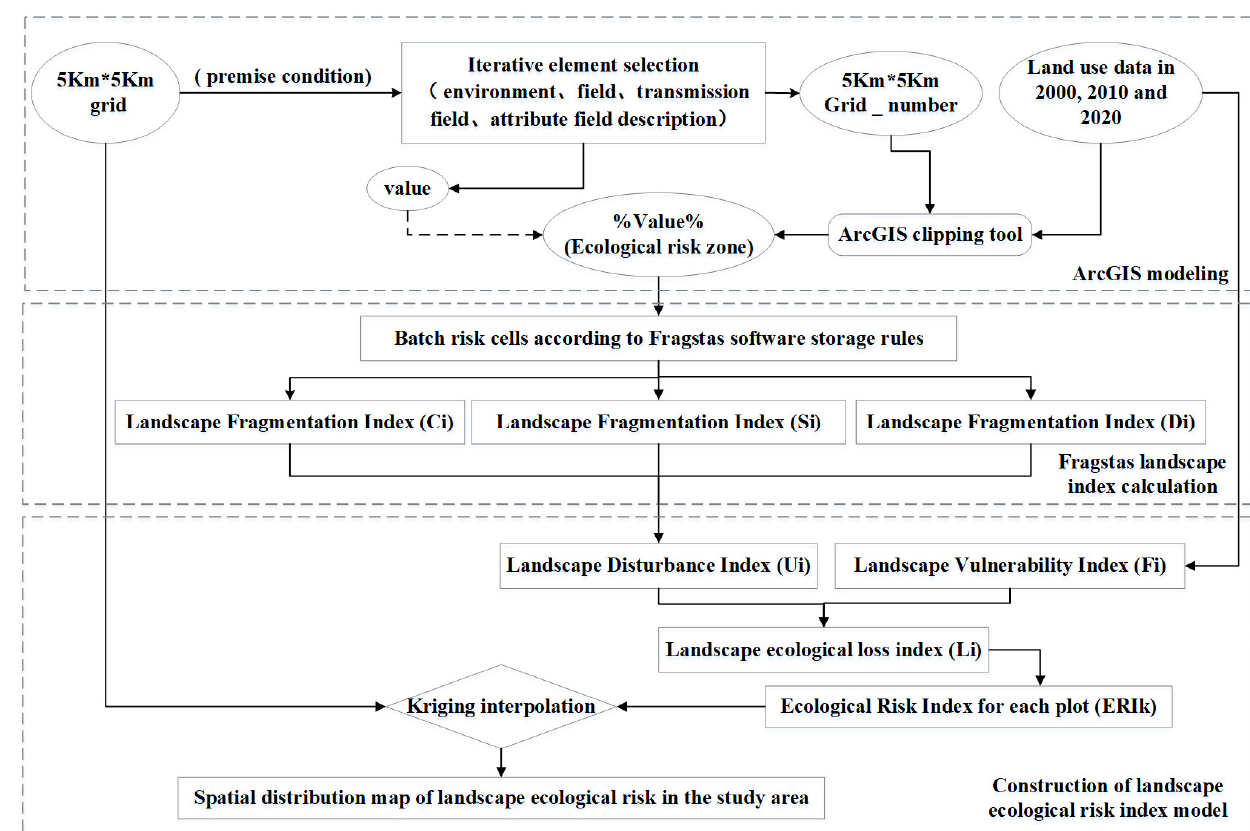
Figure 3. Flowchart for calculating the landscape ecological risk index.